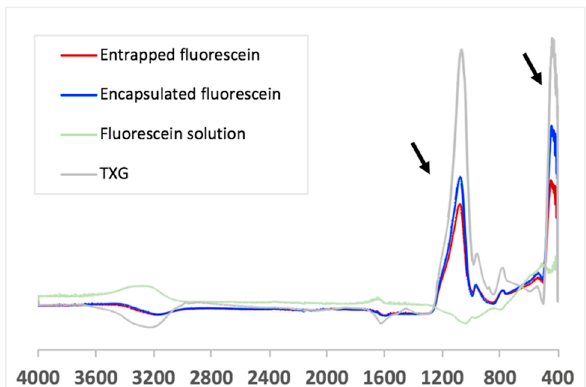
Figure 7. FTIR analysis of the two thixogels, confirming the entrapment and encapsulation of the model drug in the silica nanoparticle network. The arrows indicate the Si–O–Si specific signals (445 cm − 1 , Si–O–Si assymetrical bend; 1088 cm − 1 , Si–O stretch).